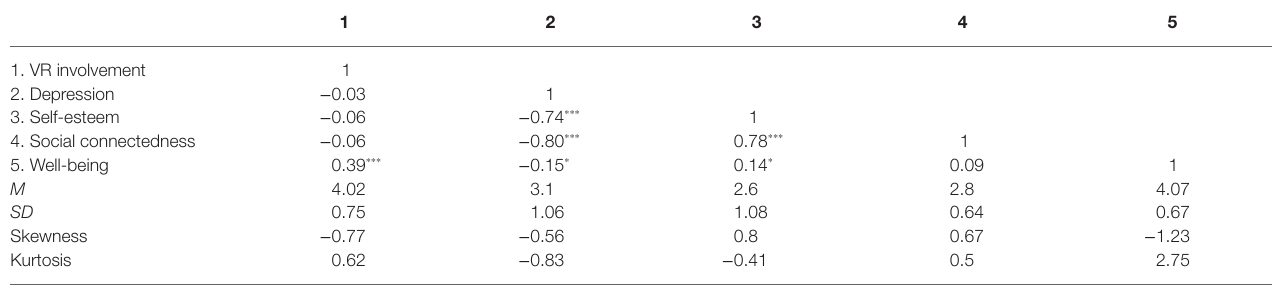
TABLE 1 | Descriptive statistics and correlations for study variables ( N = 220).